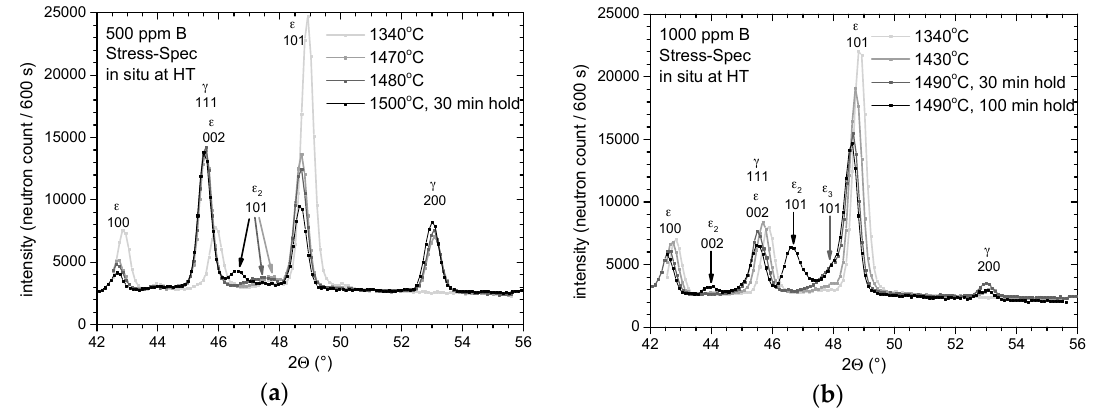
Figure 5. Evolution of HT diffractograms for ( a ) 500 ppm B and ( b ) 1000 ppm B samples nearby the highest reached temperature of 1500 °C (for 500 ppm B) and 1490 °C (for 1000 ppm B). The sequence of hcp phase splitting, which is different for both samples, can be observed.